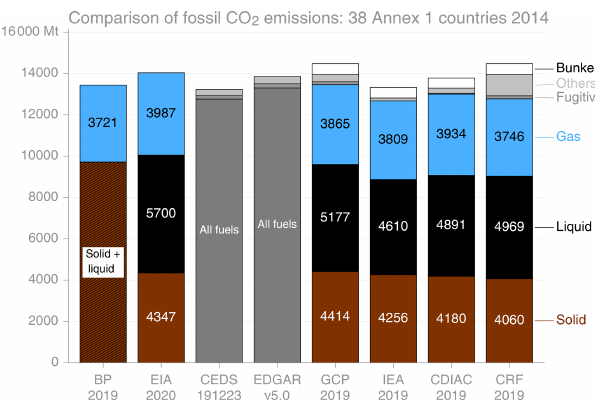
Figure 7. Comparison of fossil CO 2 emissions in most Annex 1 countries for the year 2014 from eight datasets. Smaller emitters (Cyprus, Israel, Liechtenstein, Malta) are excluded to increase the number of datasets in the